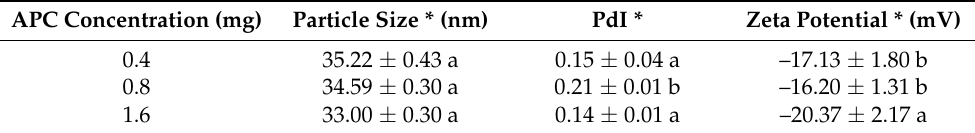
Table 5. Particle size analysis of APC-SNEDDS that contained various concentrations of APC.